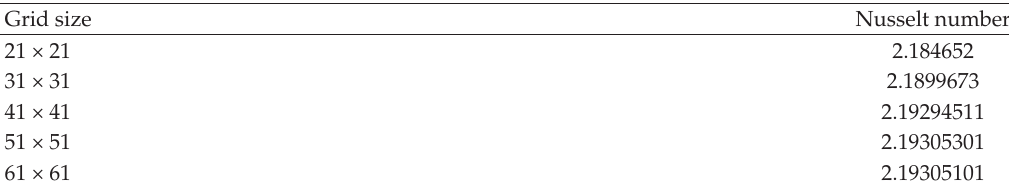
Figure 4: Cumulative heat flux plots along the left vertical wall while fixing Le (cid:8) 1, B (cid:8) 1, (cid:2) D/H (cid:3) (cid:8) 0 . 1, Ra (cid:8) 100, S C (cid:8) 0.1 for di ff erent values of “ a ”. Table 1: Nusselt number values for grid